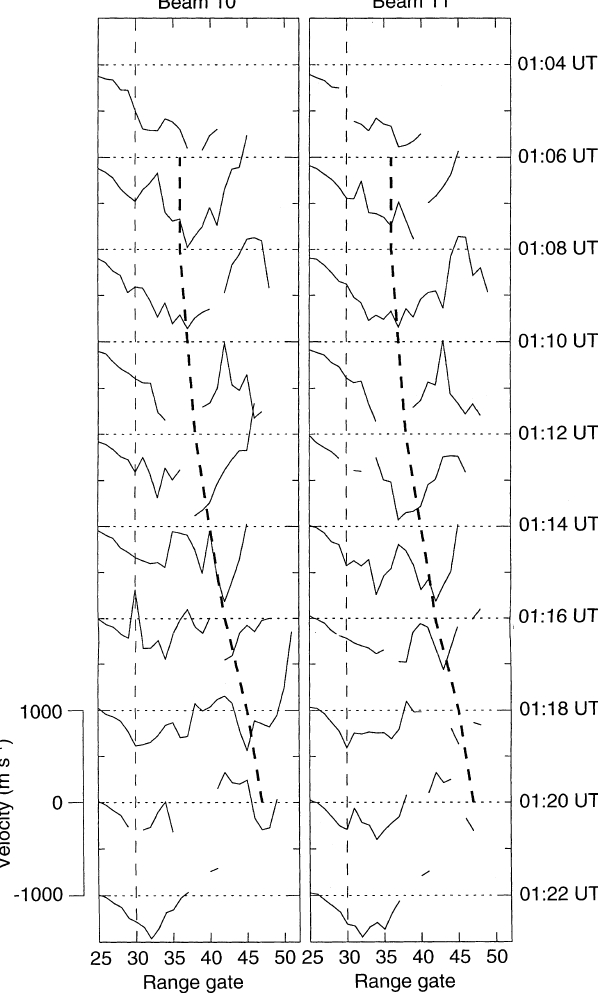
Fig. 5. Stack plots of line-of-sight backscatter velocity as a function of range gate of beams 10 and 11 between 0104 UT and 0122 UT. Range gates 25 and 50 correspond to approximately 68 (cid:176) N GMLAT and 79 (cid:176) N GMLAT. The vertical dashed line indicates the demarcation of zonal and meridional flow at 72 (cid:176) N. A poleward-progressing velocity enhancement is observed, the thick dashed line being a fit-by- eye to this